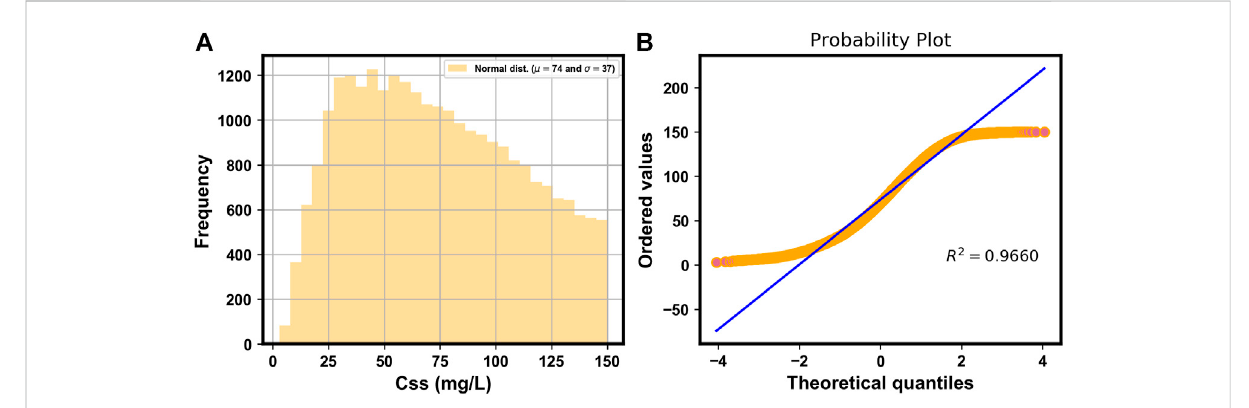
FIGURE 2 Histogram (A) and probability plot (B) of the simulated C ss of